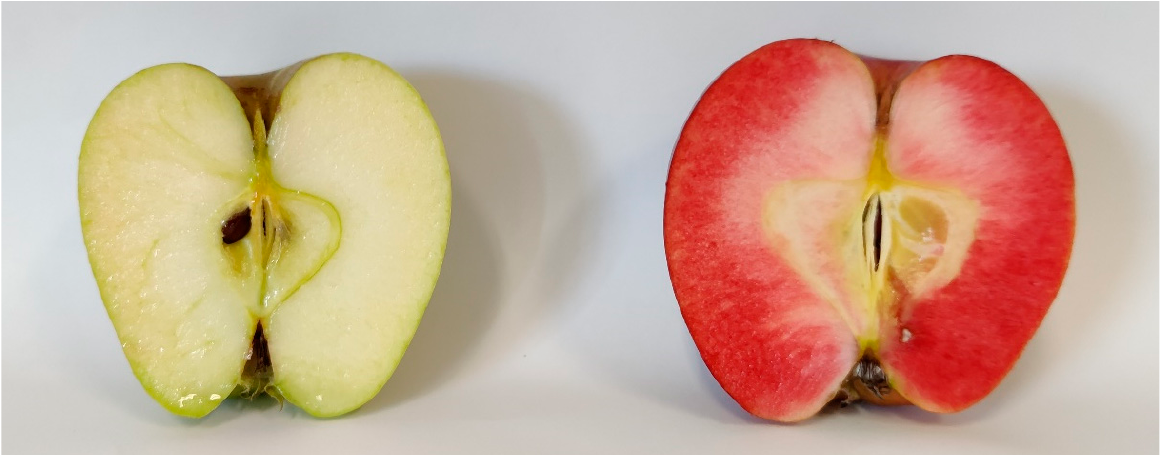
Figure 1. White-fleshed cultivar ‘ Golden Delicious ’ ( left ) compared to red-fleshed cultivar ‘ Baya Marisa ’ ( right